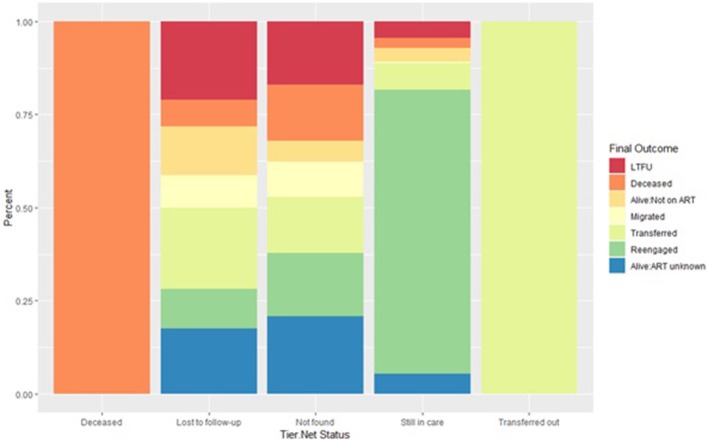
Outcome ascertained through record review and tracing stratified by each TIER.Net status. A deceased or transferred status in TIER.Net is accurate. Inaccuracies in the LTFU and still in care categories. Some patients categorized as still in care are LTFU, not currently on treatment, transfers out or dead.